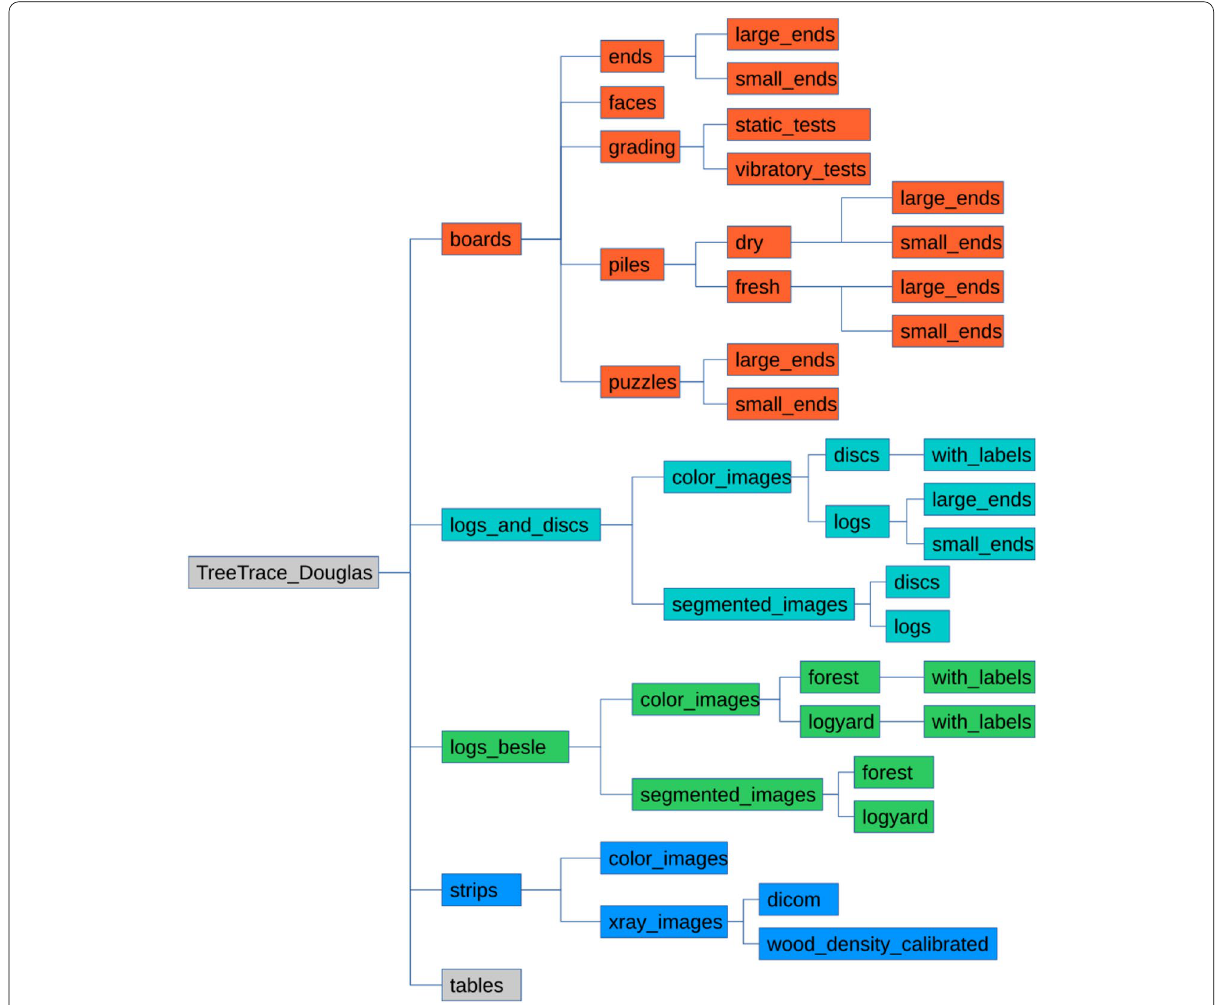
Fig. 17 Organisation of the data